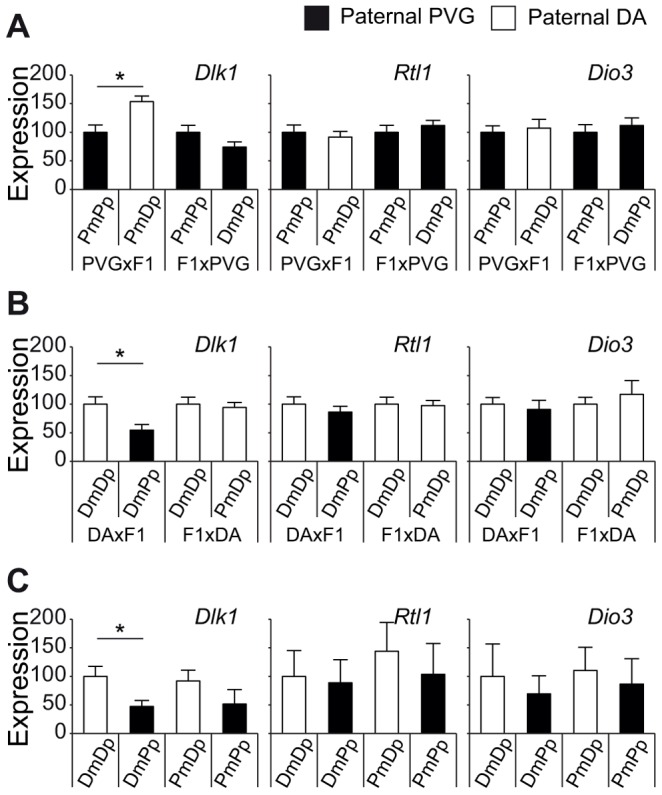
Paternally transmitted PVG allele at the Dlk1 locus predisposes for lower Dlk1 expression.
Dlk1, Rtl1 and Dio3 mRNA expression in spleen tissue collected A) 21 days after EAE induction in PVGBC population (N = 372), B) 35 days after EAE induction in DABC population (N = 347), and in C) three weeks old naïve DA, PVG and reciprocal F1 hybrid rats (N = 8–9 rats/group). A and B) Rats stratified according to the genotype at the peak of the QTL on chromosome 6 (131 Mb) showed that the paternally inherited PVG allele predisposes for lower expression of Dlk1 compared to the DA allele, whereas no effect was observed on Rtl1 and Dio3 expression. C) Likewise, F1 hybrids with paternally inherited PVG alleles demonstrated lower Dlk1 expression compared to DA alleles, whereas no effect was observed on Rtl1 and Dio3 expression. Relative Dlk1 expression was calculated in relation to the mean of housekeeping gene, hypoxanthine phosphoribosyltransferase (Hprt), using 2-ΔΔCt method and normalized within each group. P-values were calculated using Student's t-test (p-value <0.05  =  *). DA and PVG alleles are indicated with D and P, respectively, and the maternally and paternally inherited alleles are indicted with m and p, respectively.